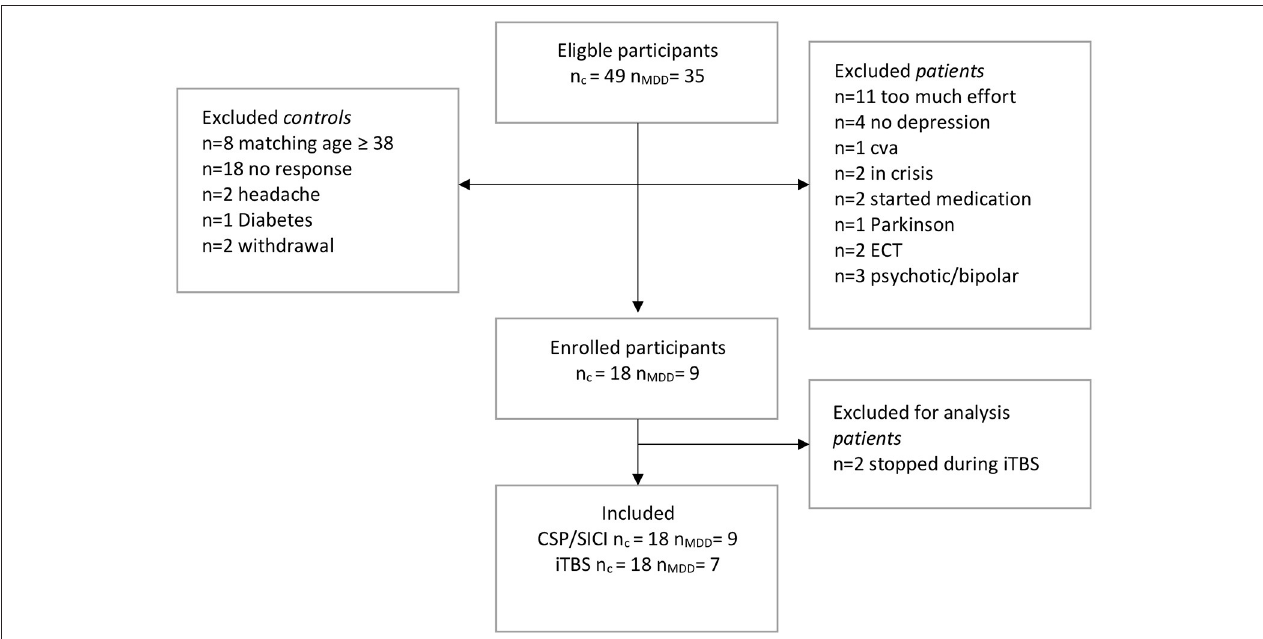
FIGURE 1 | Flow-chart of inclusions. c, control; MDD, patients with major depressive disorder; TMS, transcranial magnetic stimulation; SICI, short interval cortical inhibition; iTBS, intermittent theta-burst stimulation; CSP, cortical silent period; CVA, cerebrovascular accident; ECT, electroconvulsive therapy.